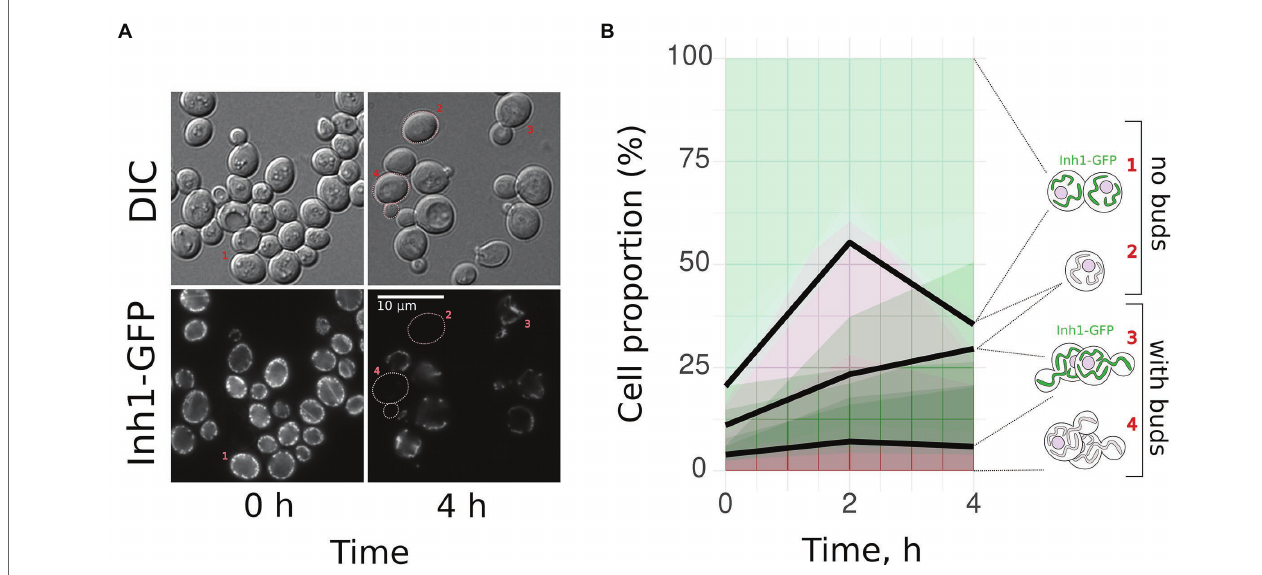
FIGURE 2 | Yeast cells with Inh1-GFP start budding faster than the cells without Inh1-GFP. Post-diauxic phase yeast cells expressing Inh1-GFP were transferred into a fresh yeast peptone dextrose (YPD) medium. We observed two types of cells: those expressing Inh1-GFP and those with no detectable GFP signal. We calculated the percentages of budded vs. unbudded cells separately for these groups. (A) Representative photograph of the cells at the beginning of the experiment and after 4 h of growth in the fresh medium. DIC—Differential Interference Contrast; (B) Change in the proportion of (1) Inh1-GFP positive non-budding; (2) Inh1-GFP negative non-budding; (3) Inh1-GFP positive budding; and (4) Inh1-GFP negative budding cells. The average proportions are shown as black lines, the results of the individual experiments are illustrated with semi-transparent green or red areas (data of five separate experiments, 369 cells on average in each data point). The number of budding cells with GFP (category 3) increased significantly more than the number of budding cells without GFP (category 4); p = 0.016 according to Wilcoxon rank sum test ( n =